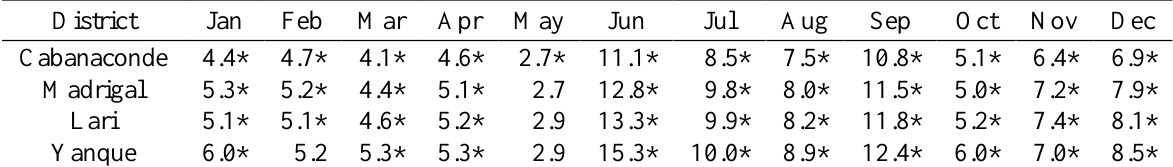
Table A 1 .2. Trends in Monthly Potential Evapotranspiration (mm) over the Period of 1988 to 2017 for the Different Districts District Jan Feb Mar Apr May Jun Dec Cabanaconde Madrigal Lari